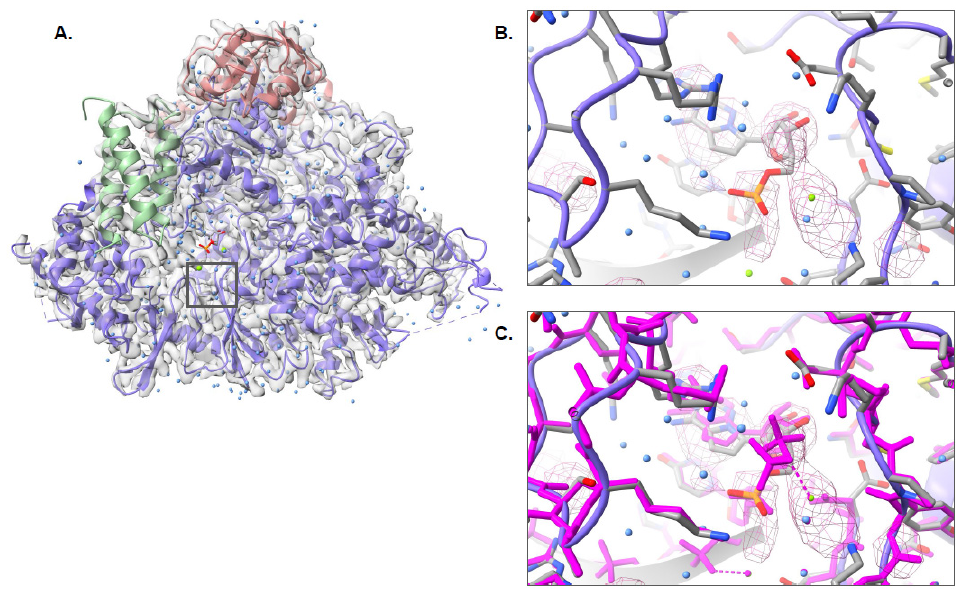
Figure 6. Pathwalking and ligand identification: EMD-30210. The complete Pathwalking model for SARS-CoV-2 RNA-dependent RNA polymerase, including waters (blue) and ligands (gray) is shown in ( A ). A zoomed-in view of the identified ligand location, marked by a square in ( A ), by pw_ligands.py is shown as a cage in ( B ). The fitted and refined ligand, along with the water (blue) and protein models (colored by chain) are shown as well. In ( C ), the published model (magenta) is shown superimposed on the Pathwalking model.